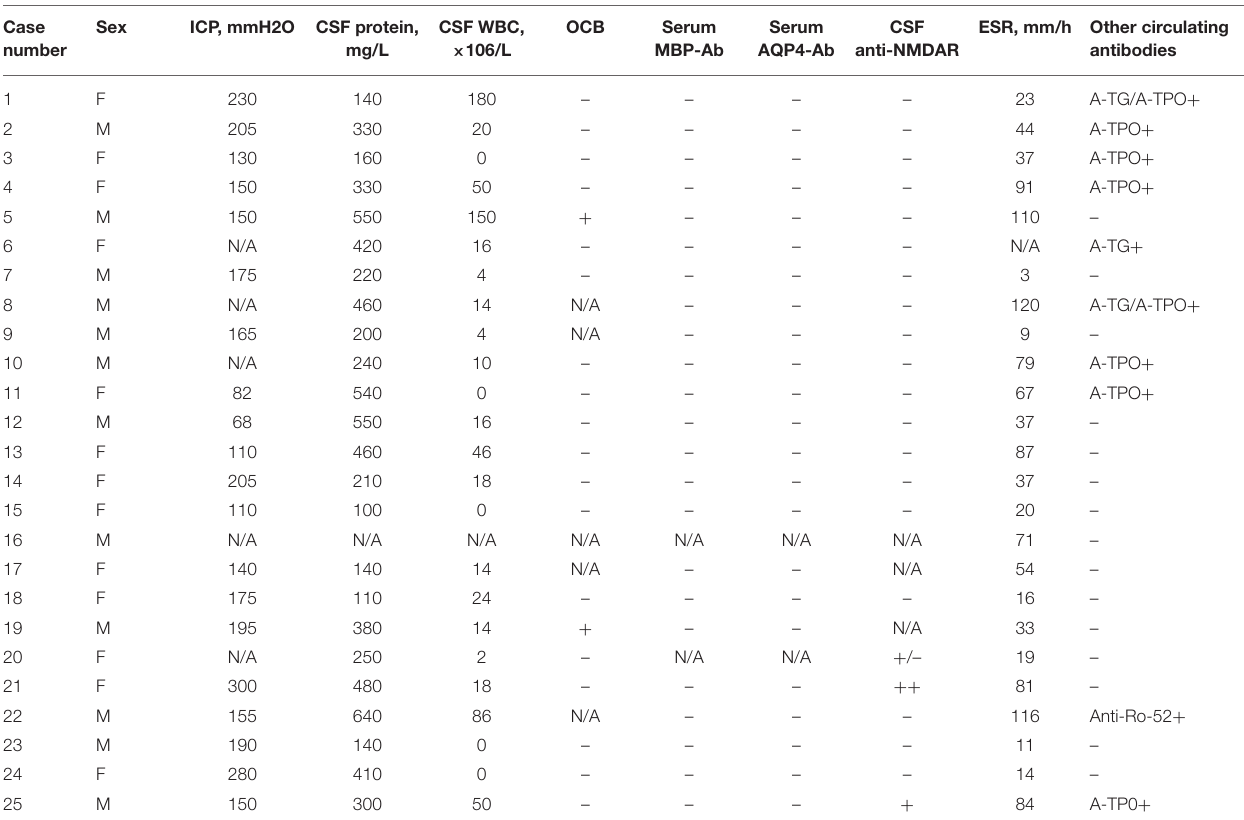
TABLE 3 | The laboratory findings at first episode.